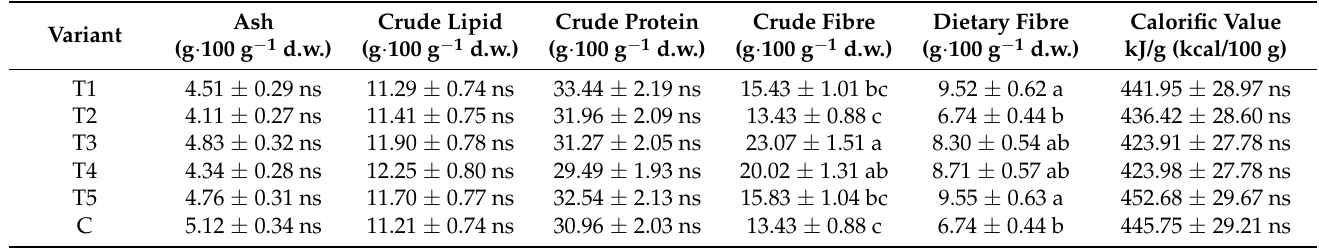
Table 6. The proximate composition of tomato fruits under different electric current treatments. Variant